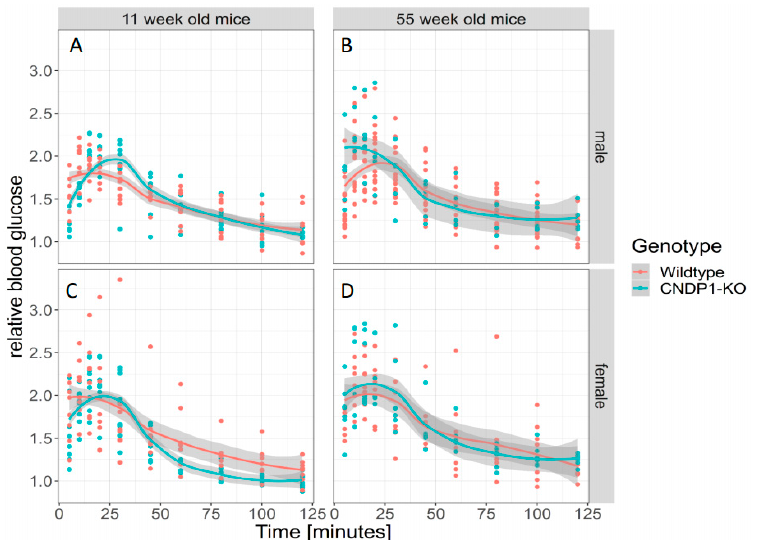
Figure 9. Intraperitoneal Glucose Tolerance Test (IP-GTT) in 11-week-old male ( A ) and female ( C ) Cndp1 -KO and WT mice and in 55-week-old male ( B ) and female ( D ) Cndp1 -KO and WT mice. Blood glucose concentrations on y -axis is given relative to basal blood glucose level. GAMM analysis did neither reveal an effect of genotype nor of gender on blood glucose levels over 120 min (11 weeks male Cndp1 -KO: n = 8; 11 weeks male WT: n = 9; 11 weeks female Cndp1 -KO: n = 8; 11 weeks female WT: n = 9; 55 weeks male Cndp1 -KO: n = 17; 55 weeks male WT: n = 5; 55 weeks old Cndp1 -KO female: n = 8; 55 weeks old female WT: n = 7).